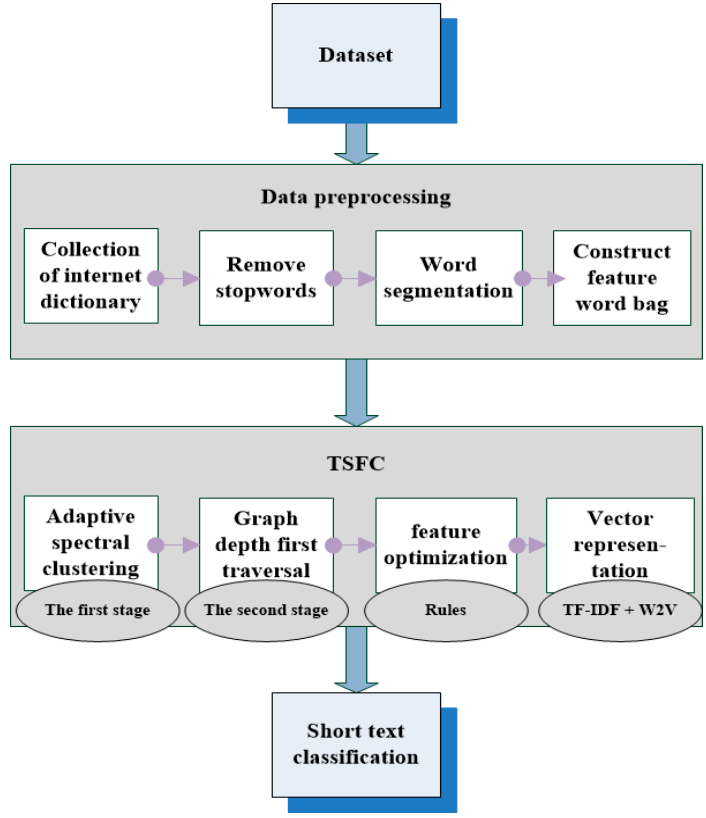
Table 1. Symbols and their definitions.